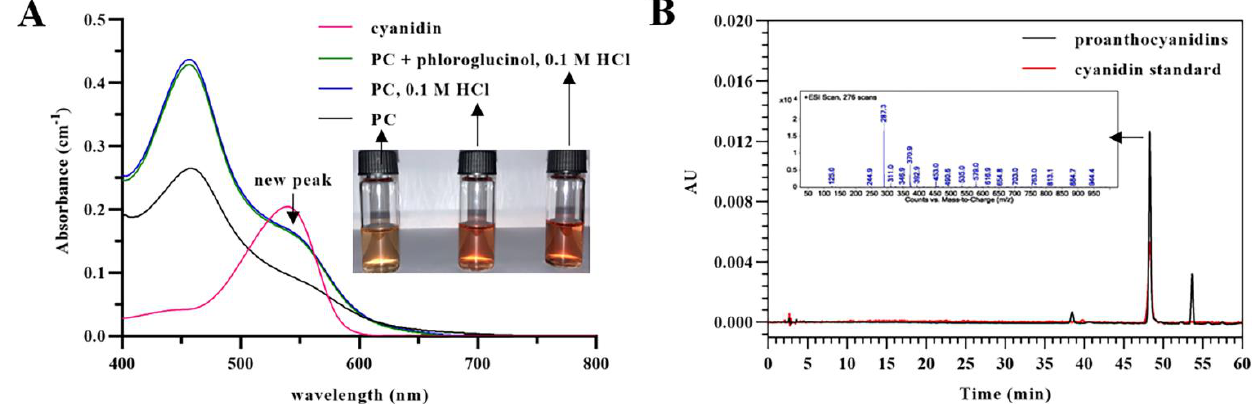
Figure 2. Acid-catalyzed transformation of proanthocyanidins purified from grape seed extract into cyanidin. ( A ) Optical absorption spectra of cyanidin, proanthocyanidins in pure methanol, and proanthocyanidins after acid catalysis in the presence of excess phloroglucinol or not (insets are visual images of the methanolic solutions of proanthocyanidins). ( B ) HPLC chromatograms of cyanidin standard and proanthocyanidins after acid catalysis in the presence of excess phloroglucinol at 550 nm (inset is a mass spectrum of the peak detected at 48.29 min after acid catalysis). 3.2. The Effect of Cyanidin Formation on the Molecular Weight Distribution of